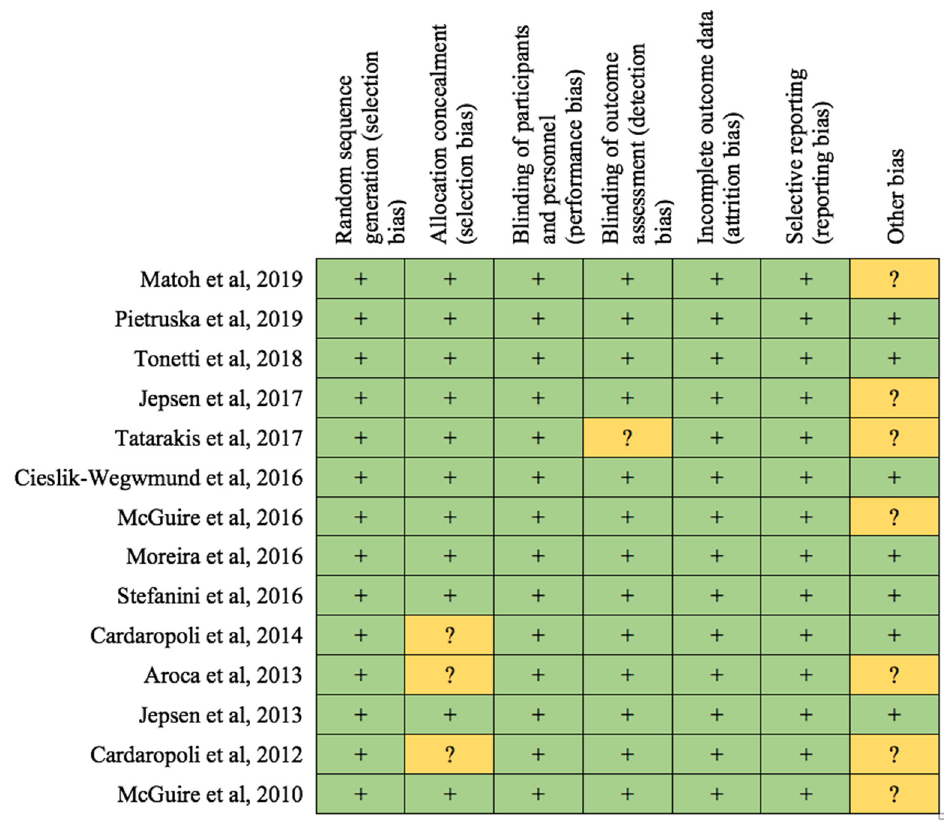
Figure 3. Assessment of risk of bias.